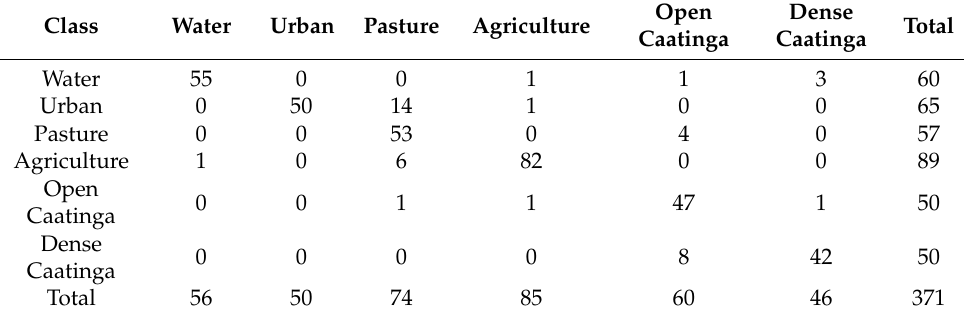
Table A2. Confusion matrix year 2000.